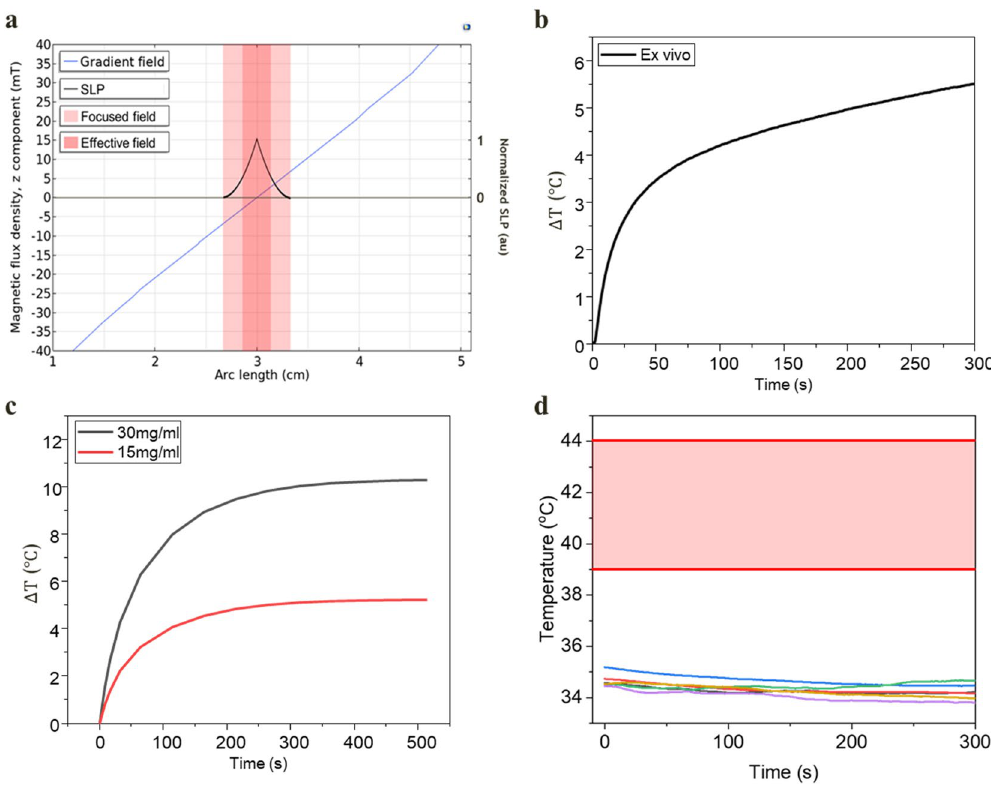
Figure 1. Simulation and experimental results of temperature control. ( a ) FFP area, with the generated gradient field and SLP inside the area. The FFP is generated up to a distance where the gradient field and external field strength match, which is equivalent to the theoretical calculated distance of 7 mm. The theoretically expected size of the FFP can be calculated by the magnetic field H and gradient field G; that begins at the boundary becomes stronger as it approaches the center ( SLP ∝ H be expected to generate heat up to 3.5 mm in diameter, which is approximately half of its maximum size. ( b ) Ex vivo temperature increase with 15 mg/mL concentration. ( c ) Simulation results of temperature increase in vivo using different concentrations. ( d ) The brain baseline temperature before magnetic stimulation was maintained at 34 °C (n = 6), which was slightly lowered by anesthesia. The range of 39°–44° was set for the experiment to induce stimulation and change of BBB